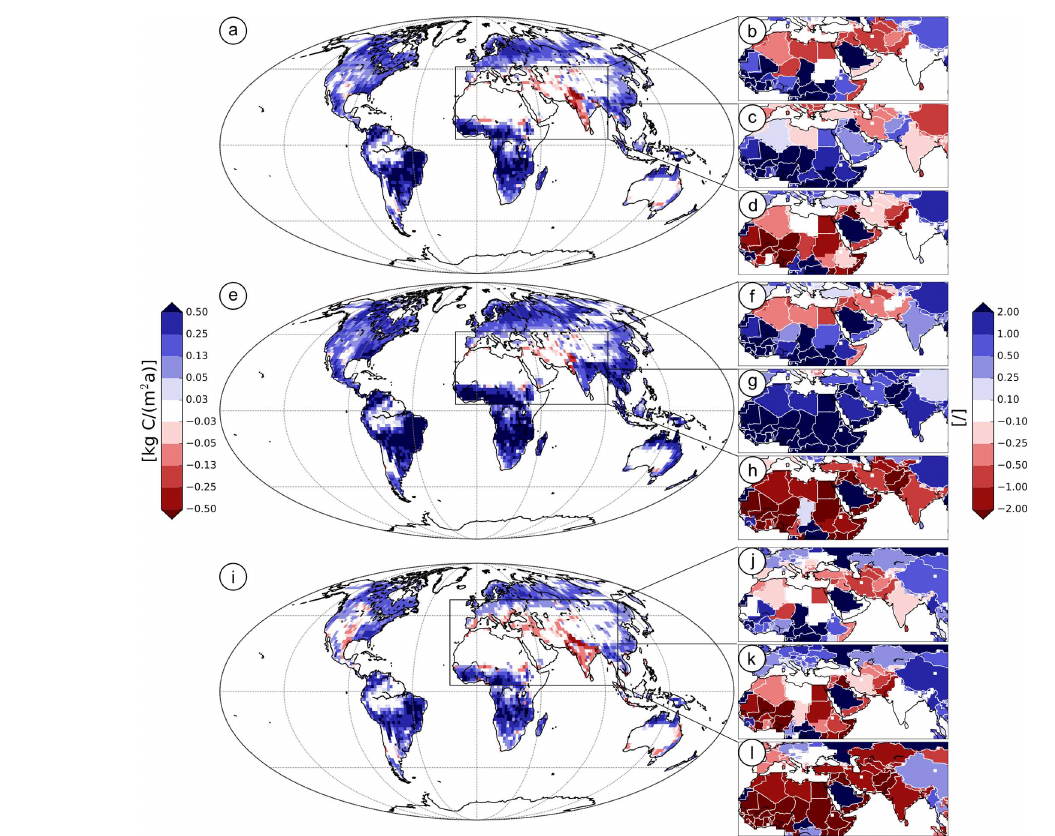
Figure 6. Agricultural land, regional food production and population. (a) Productivity differences between the year 2100 in the RCP2.6 simulation and the present day (REF). The changes in net primary productivity are aggregated to the total (grid box) area, so they show the combined effect of changes in the productivity of crops and changes in the spatial extent of croplands. (b) Relative difference in food production between 2100 (IR26) and the present day (REF). (c) Relative population change until 2100 for the high-fertility scenario (UN, 2015a). (d) Difference between the relative changes in food supply and in population (note that to account for the share of imports in the overall supply, we assumed constant import levels corresponding to the year 2005, and the food supply for net importers was estimated from the domestic food production and the cereal import dependency ratio; FAO, 2016b). (e–h) Same as (a–d) but for RCP8.5 and the high-fertility scenario. (i,j) Same as (e,f) but without the CFE. (k) Difference between the relative changes in food supply and in population for the low-fertility and low-life-expectancy scenario. (l ) Same as (k) but for the high-fertility and high-life-expectancy